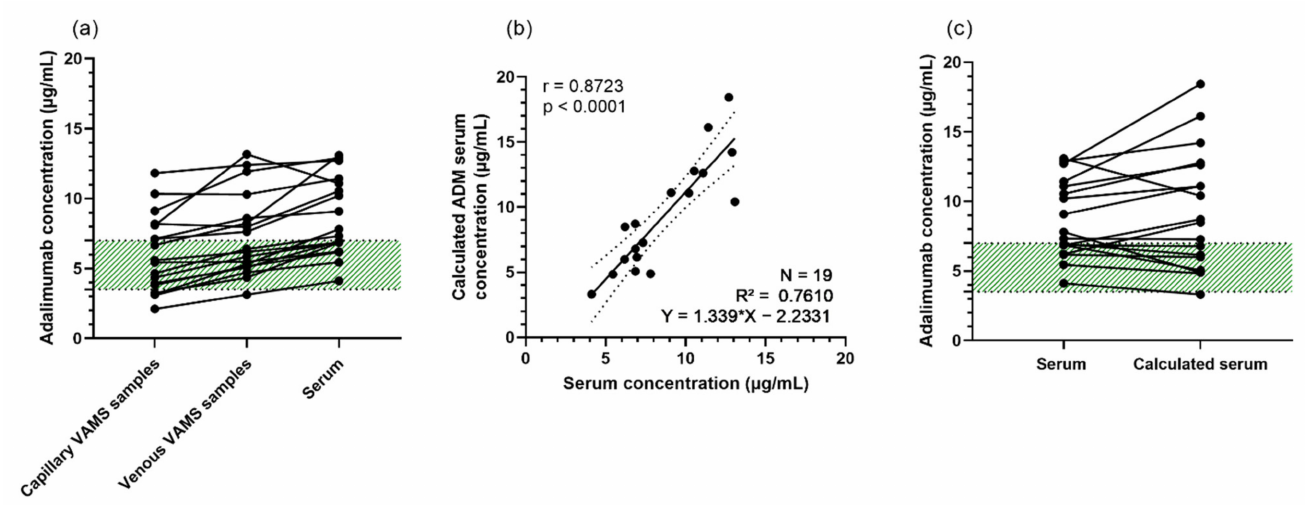
Figure 6. Concordance between capillary VAMS samples, venous VAMS samples and calculated serum (based on a blood-serum and capillary-venous correction factor). ( a ) ADM ( µ g/mL) in the three matrices, capillary VAMS samples, venous VAMS samples and serum. Green range represents the therapeutic window of ADM (3.51–7.0 µ g/mL [8,9]) ( b ) Pearson correlation of ADM concentrations obtained from serum samples ( X -axis) and calculated ADM serum concentrations based on a blood- serum correction factor of 1.22 and a capillary correction factor of 1.28 ( Y -axis). ( c ) ADM ( µ g/mL) in serum (gold standard) and calculated ADM serum concentration, based on a blood-serum correction factor of 1.22 and a capillary-venous correction factor of 1.28. Green range represents the therapeutic window of ADM (3.51–7.0 µ g/mL [8,9]). Abbreviations: ADM—adalimumab;